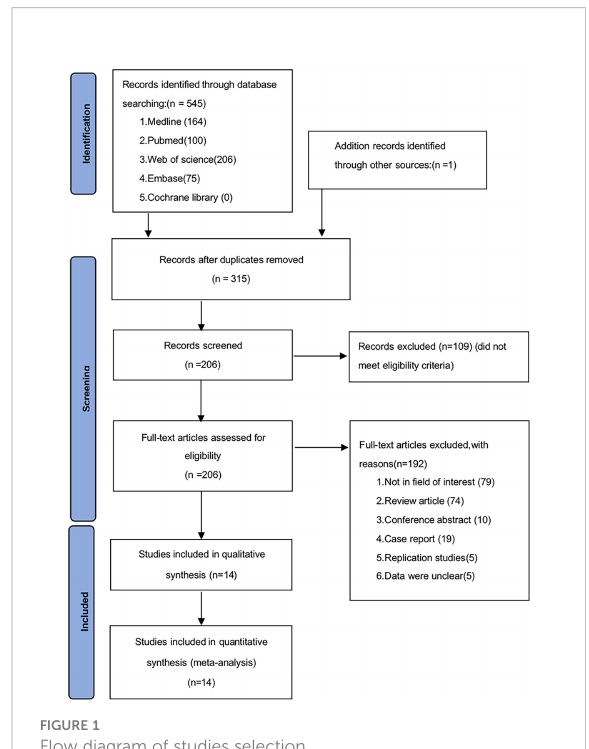
FIGURE 1 Flow diagram of studies